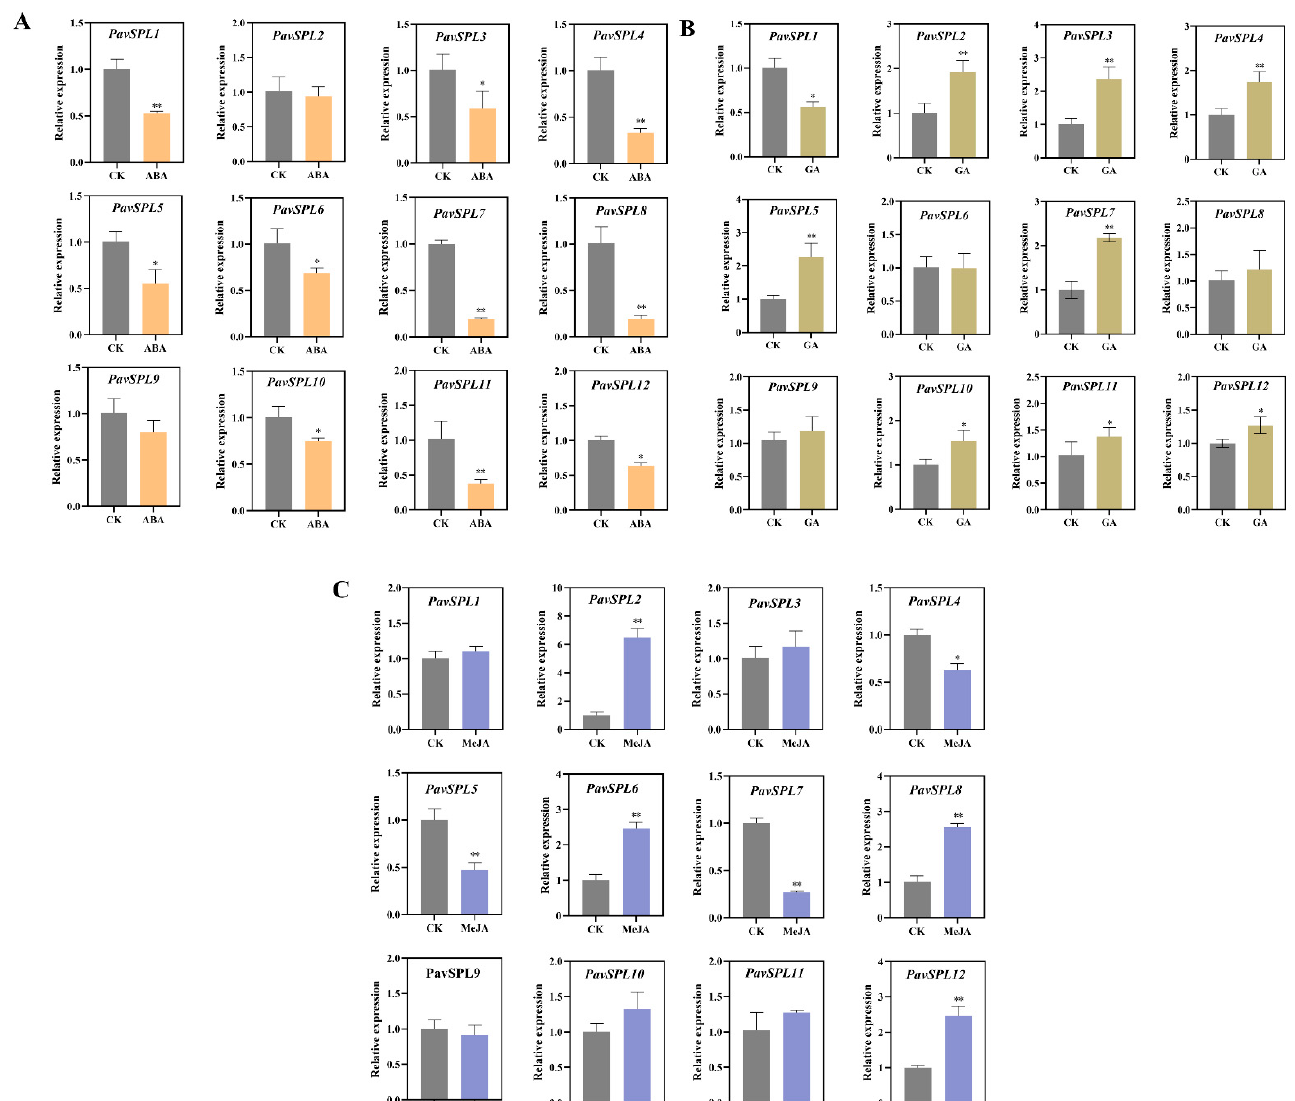
Figure 8. ( A ) ABA treatment, ( B ) GA treatment, ( C ) MeJA treatment. Expression patterns of PavSPL genes under ABA, GA, and MeJA treatments. The relative mRNA levels are represented as the means ± SDs ( n = 3). Statistically significant differences were assessed using Student’s t -test (* p < 0.05, ** p < 0.01).